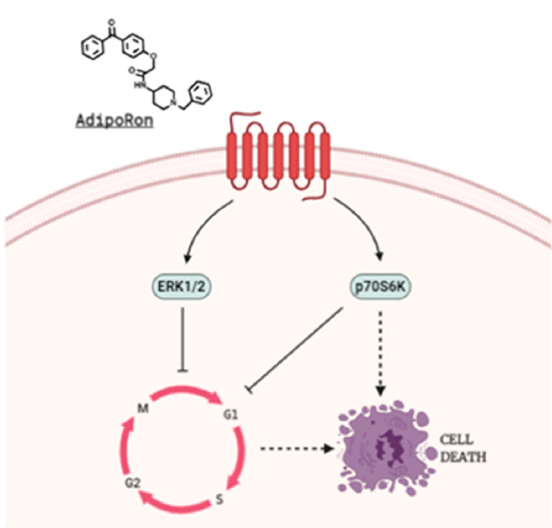
Figure 2. Theoretical proposed AdipoRon-mediated mechanism of action in Saos-2 Osteosarcoma cells.